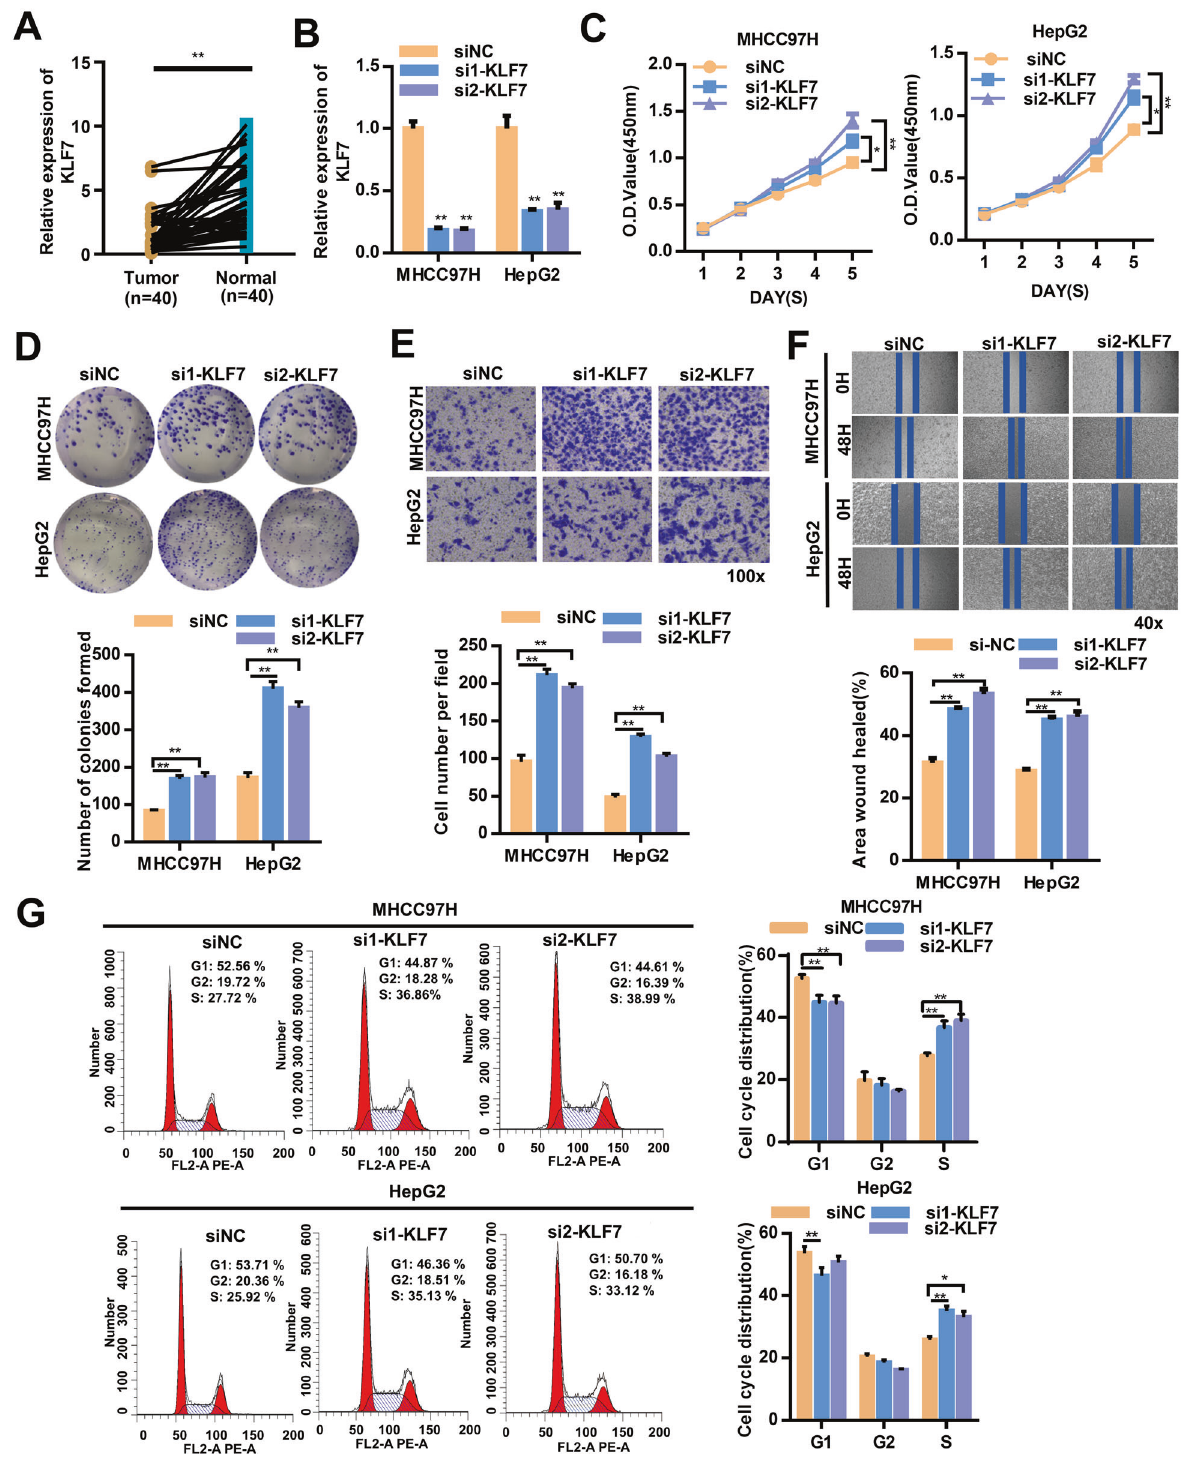
Fig. 7 KLF7 inhibits the proliferation, wound healing, and migration of MHCC97H and HepG2 cells in vitro. A qRT-PCR detection show the differential expression of KLF7 in 40 paired HCC tissues. B qRT-PCR detection showing the expression of KLF7 in both MHCC97H and HepG2 cells after transfection with siRNA against KLF7 or negative control. C CCK8 assays were used to evaluate cell proliferation. D Colony formation assay showing proliferation in both MHCC97H and HepG2 cells. E The migration of HCC cells. F The wound-healing assays. G Flow cytometry detection showing the percentages of cells in G1, S, or G2 phase in both MHCC97H and HepG2 cells. Data are presented as mean ± SD, n = 3. * p < 0.05, ** p < 0.01; NS no signi fi cance.